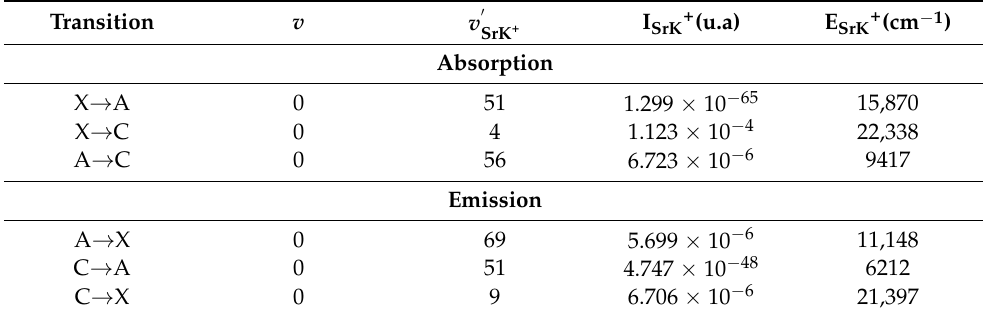
Table 1. Energypositions of the maximum intensities for each absorption and emission transition for (SrK) + .